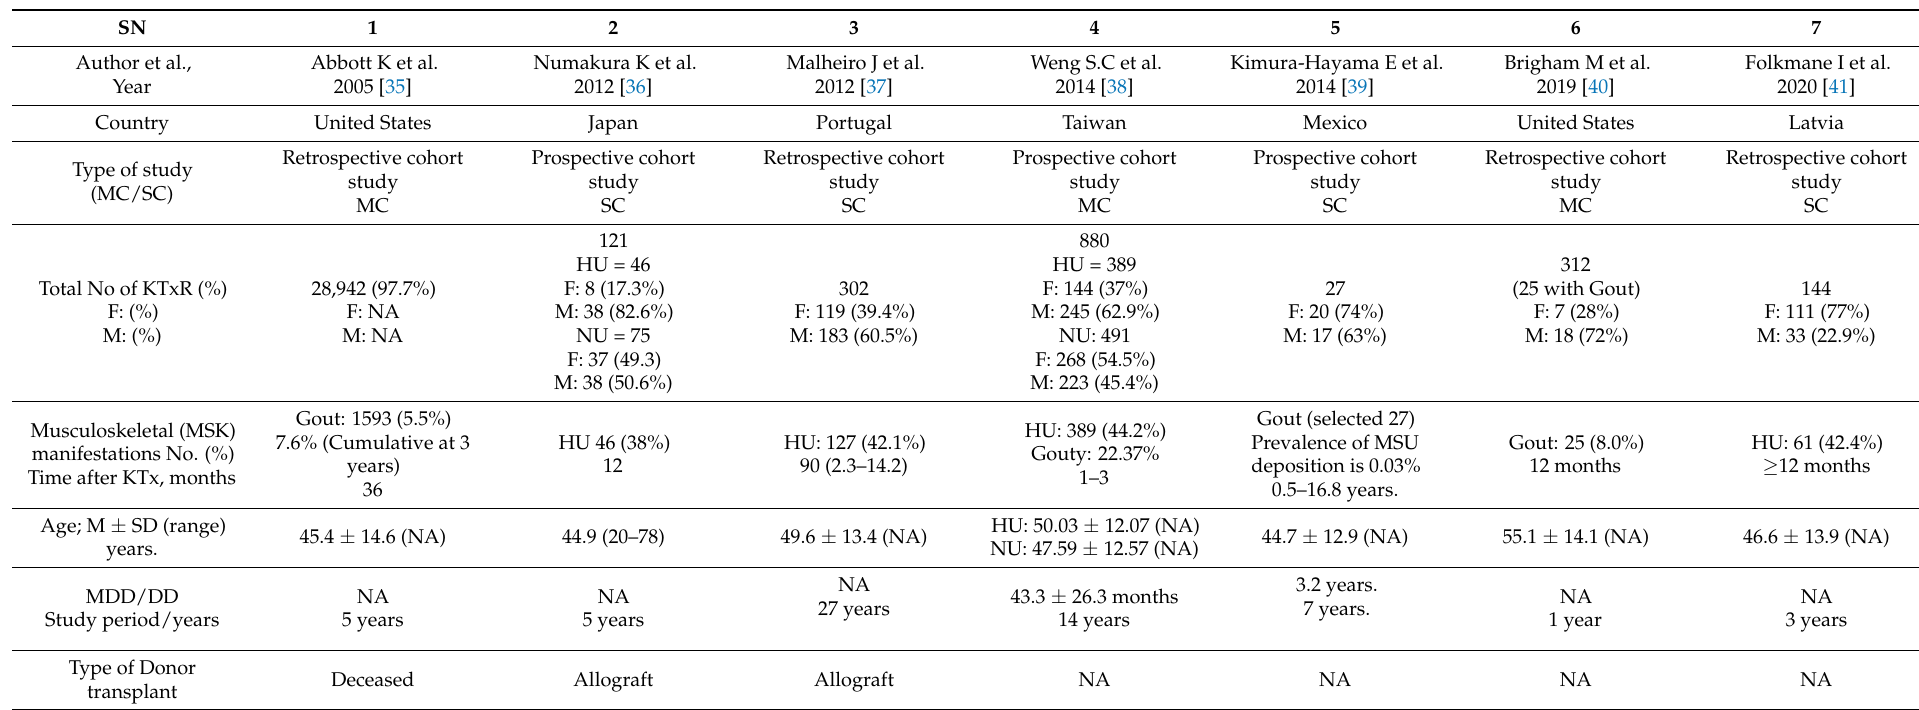
Table 2. Prevalence of hyperuricemia and gout in adult post kidney transplant recipients (KTxR) included in this systematic review. SN